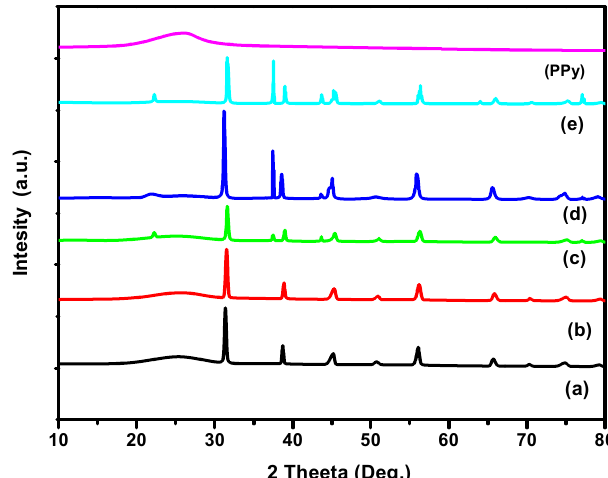
Figure 5. XRD patterns of ( a ) PPy/1% BaTiO 3 , ( b ) PPy/2% BaTiO 3 , ( c ) PPy/3% BaTiO 3 , ( d ) PPy/4% BaTiO 3 and ( e ) PPy/5% BaTiO 3.